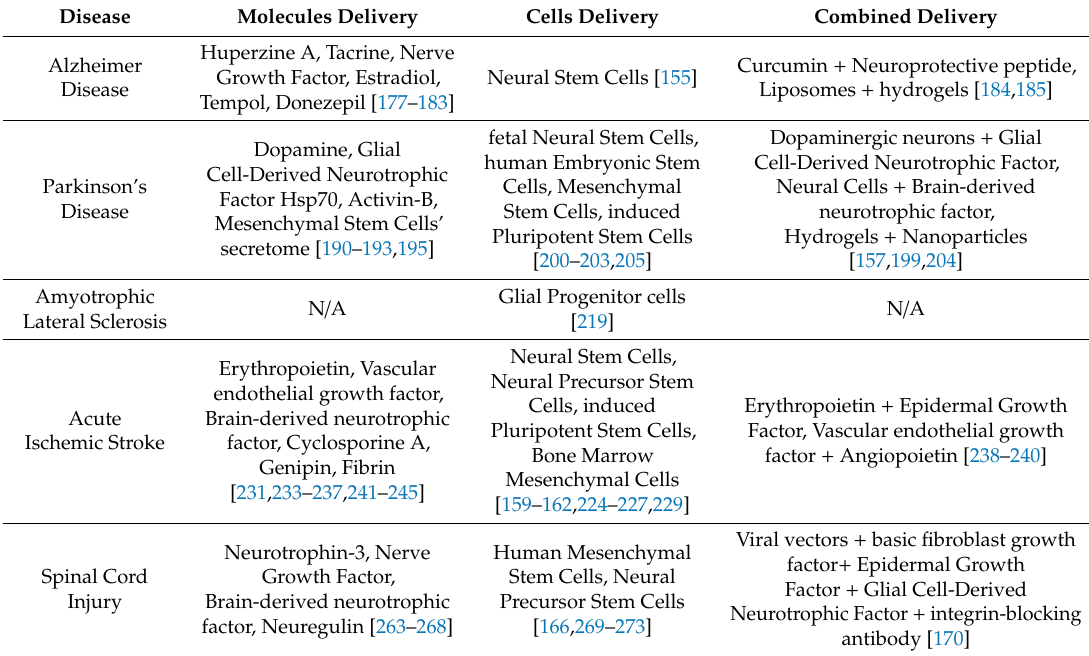
Table 2. Summary of therapeutic agents delivered with sca ff olds to treat neurodegenerative diseases.